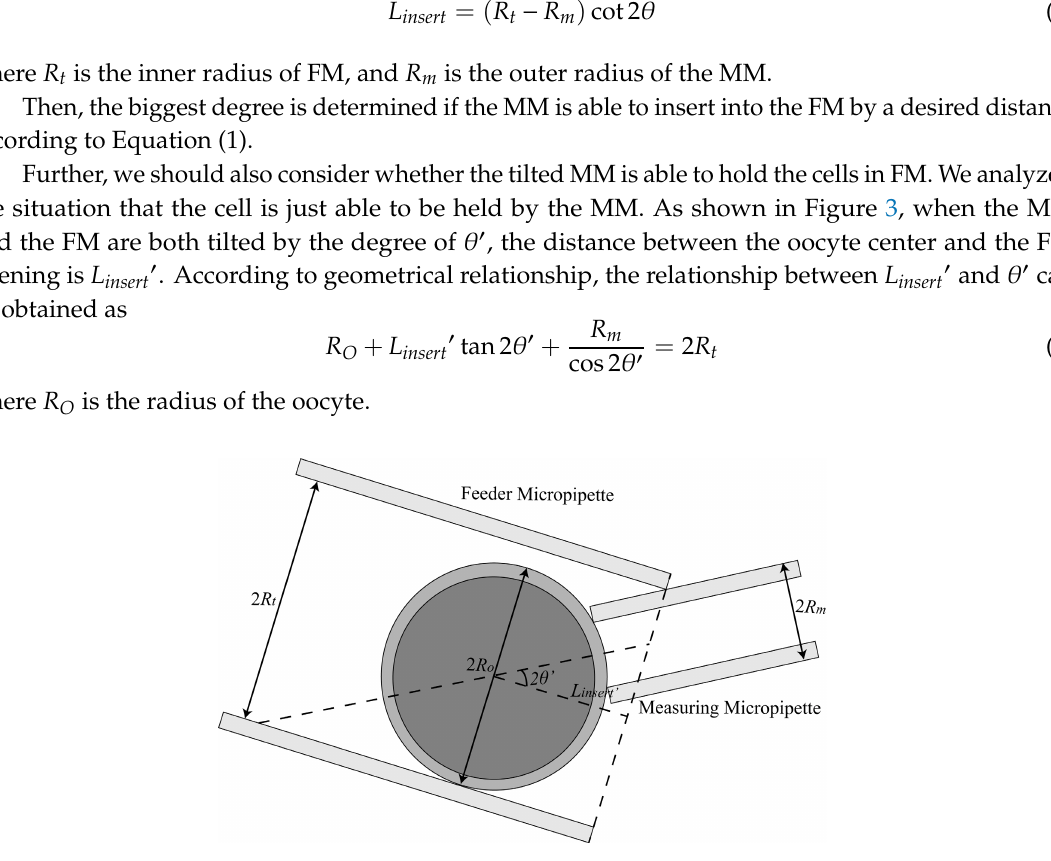
Figure 3. Schematic: The cell almost cannot be aspirated by the tilted measuring micropipette (MM).